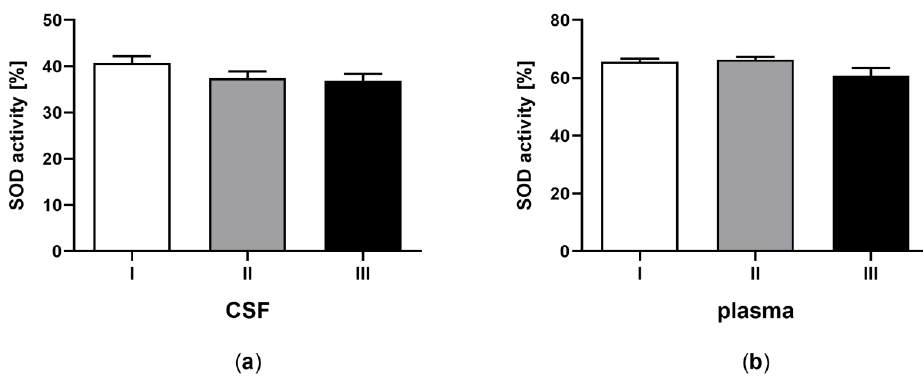
Figure 3. Total ascorbate concentration in CSF (a) and plasma (b) of the patients in MCS before (white bars) and after first (grey bars) and second (black bars) transplantation of BM-MSC. The statistical analysis was determined by a one-way ANOVA followed by Tukey’s multiple comparison test ( p < 0.05). Asterisks indicate differences in the antioxidant capacity between examining groups (* p < 0.05; ** p < 0.001).